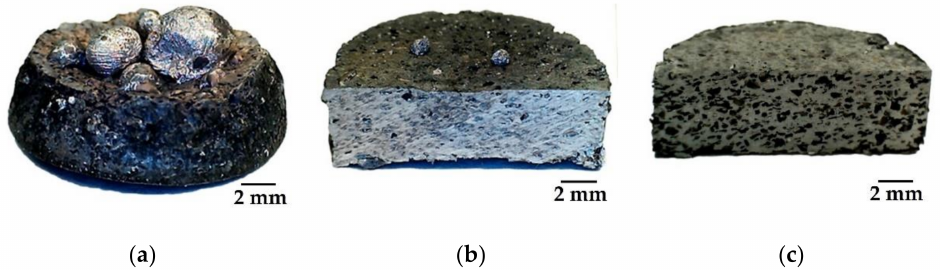
Figure 5. Foams designed with 50 vol.% porosity, sintered at a maximum temperature of ( a ) 600 ◦ C, ( b ) 550 ◦ C and ( c ) 500 ◦ C.